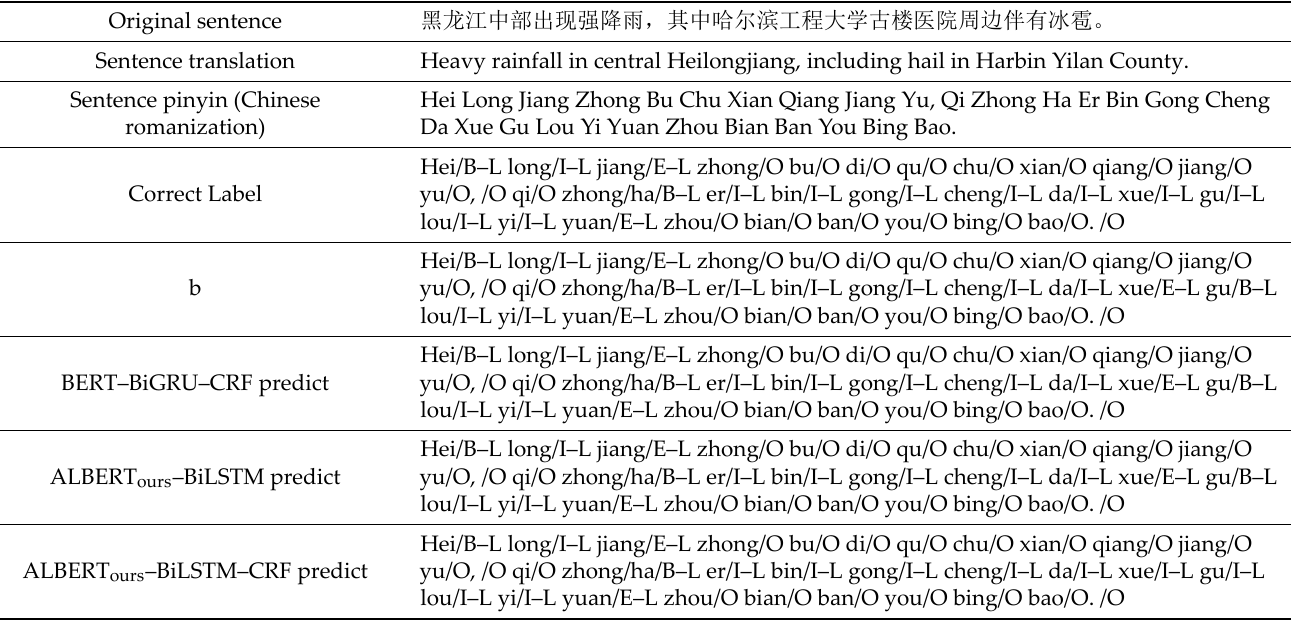
Table 13. Results of an instance being predicted by different models. B represents begin, I represents inside, E represents end, and O represents